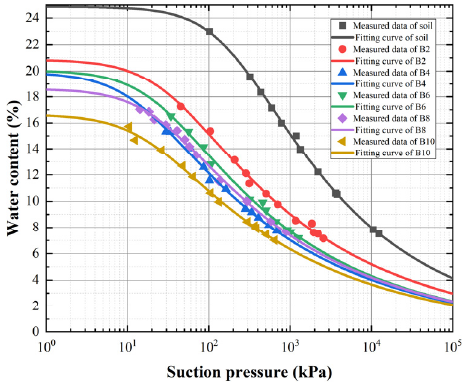
Figure 8. Changes in SWCCs under different action times of SMS-B.